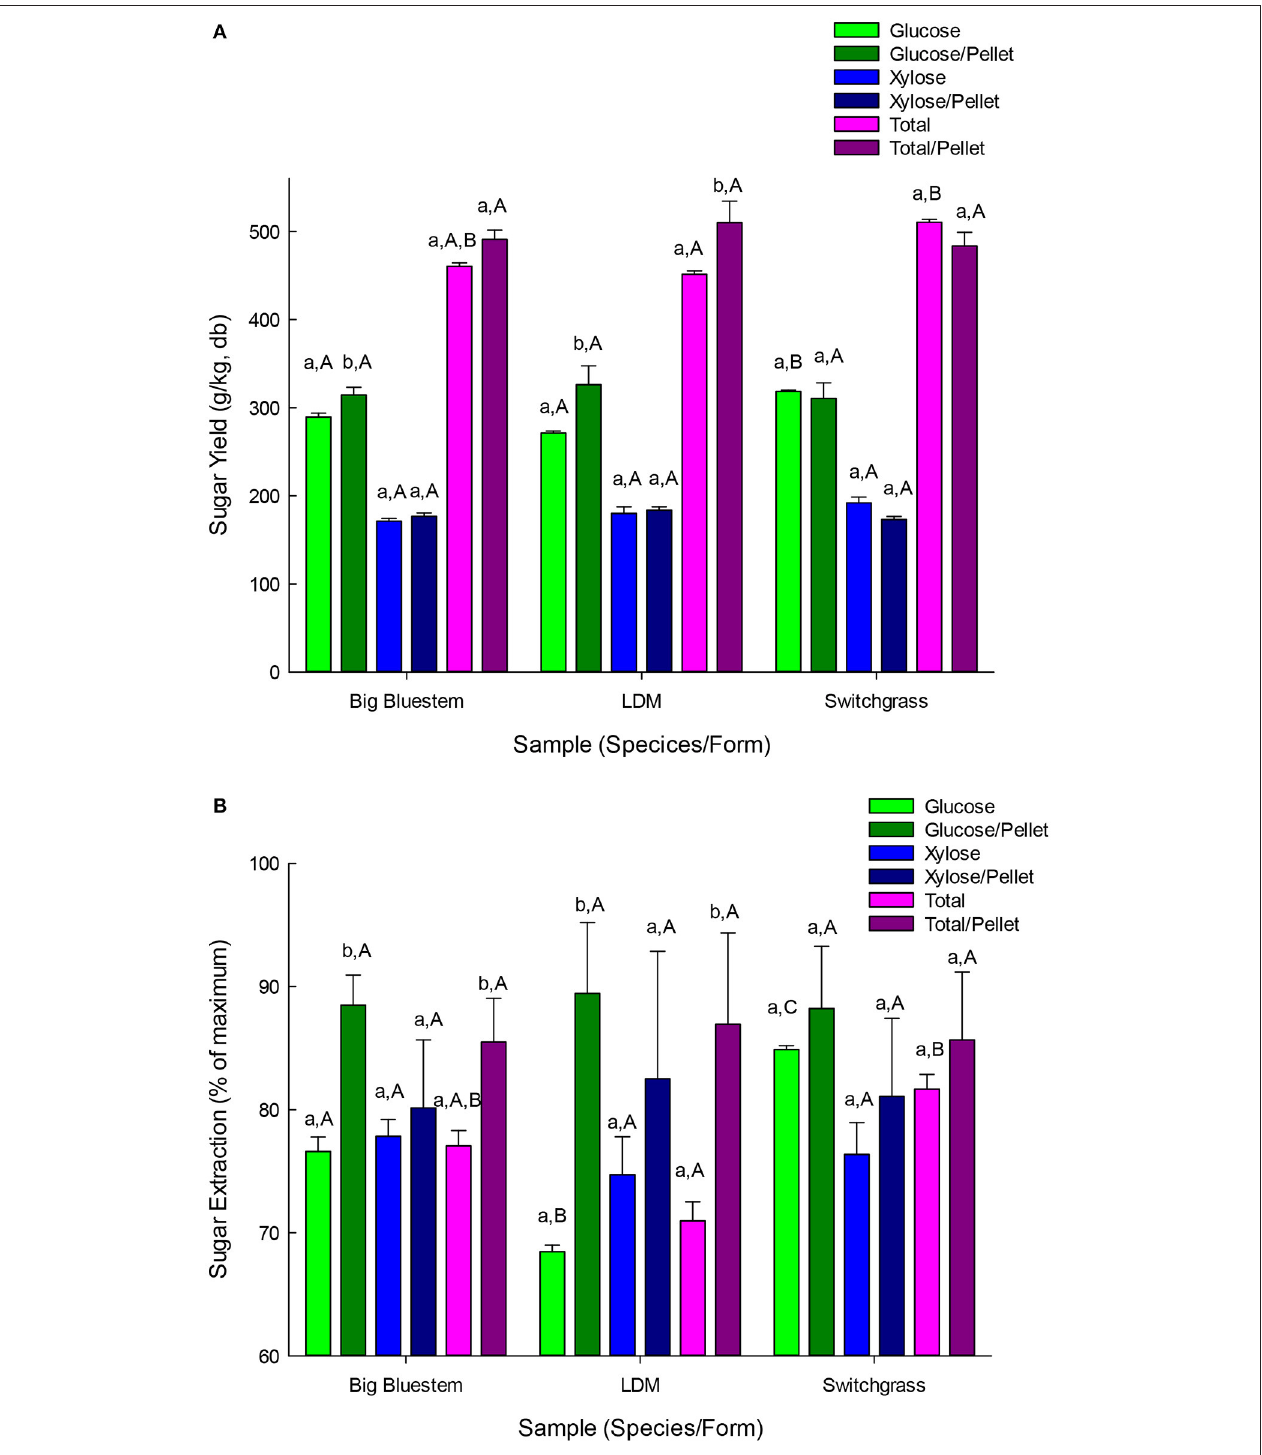
FIGURE 5 | (A) Yield of neutral sugars from pelletized and non-pelletized samples pretreated with LMA pretreatment followed by enzyme hydrolysis using commercial cellulases and hemicellulases. Results are mean of triplicate runs and error bars are standard deviations. Different lower-case letters represent significant differences based upon pellet vs. non-pellets and different capital letters represent significant differences based upon species for either pelleted or non-pelleted samples ( p < 0.05). (B) Sugar yield efficiencies (e.g., % sugars recovered) from pelletized and non-pelletized samples pretreated with liquid hot-water pretreatment followed by enzyme hydrolysis using commercial cellulases and hemicellulases. Results are mean of triplicate runs and error bars are standard deviations. Different lower-case letters represent significant differences based upon pellet vs. non-pellets and different capital letters represent significant differences based upon species for either pelleted or non-pelleted samples ( p <